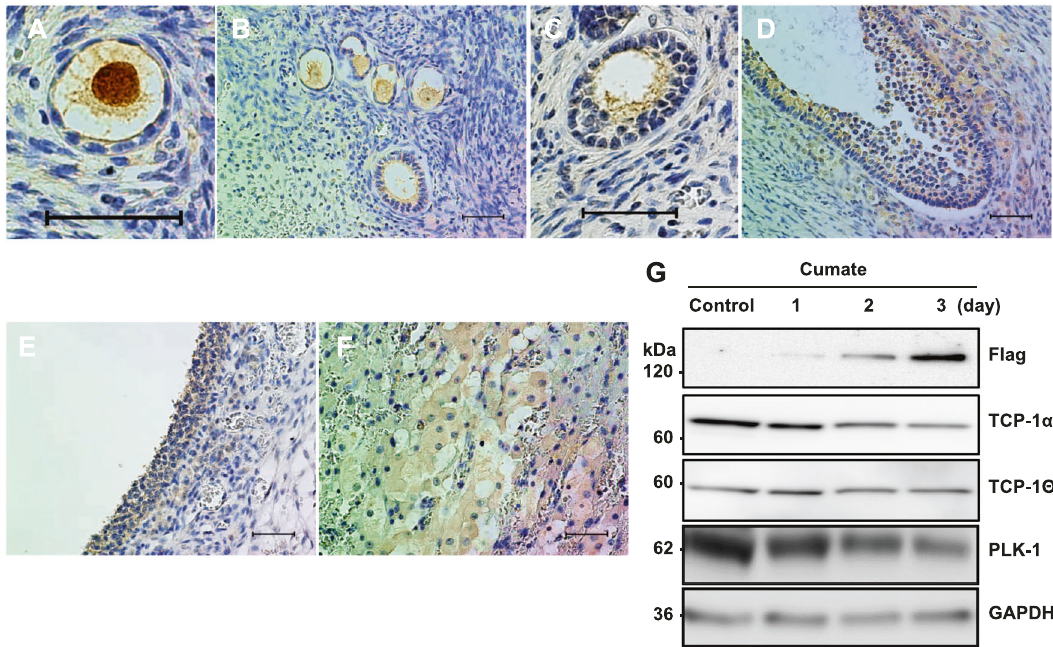
Fig. 5 Expression of TCP-1 α in human granulosa cells in vivo and in vitro. Representative IHC images of TCP-1 α staining in serially sectioned human normal ovarian tissue. A Primordial follicle. B Primary follicle. C Secondary follicle. D Small antral follicle. E Large antral follicle. F Corpus luteum. Scale bars, 50 µm. G Relative levels of target proteins in CuO-POTEF-Flag HGrC1 cells with POTEF expression. Cell lysates were western blotted with anti-Flag, anti-TCP-1 α , anti-TCP-1 θ , and anti-PLK1 antibodies. Amounts of two CCT component proteins and PLK1 did not drastically change with the presence of POTEF protein. GAPDH was used as the